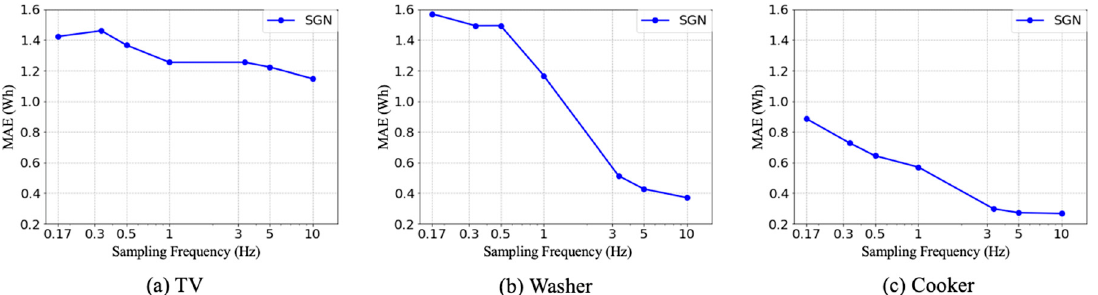
Figure 11. Sensitivity of the regression algorithm to the sampling rate. Sensitivity of SGN is shown where a smaller value is desired for MAE.